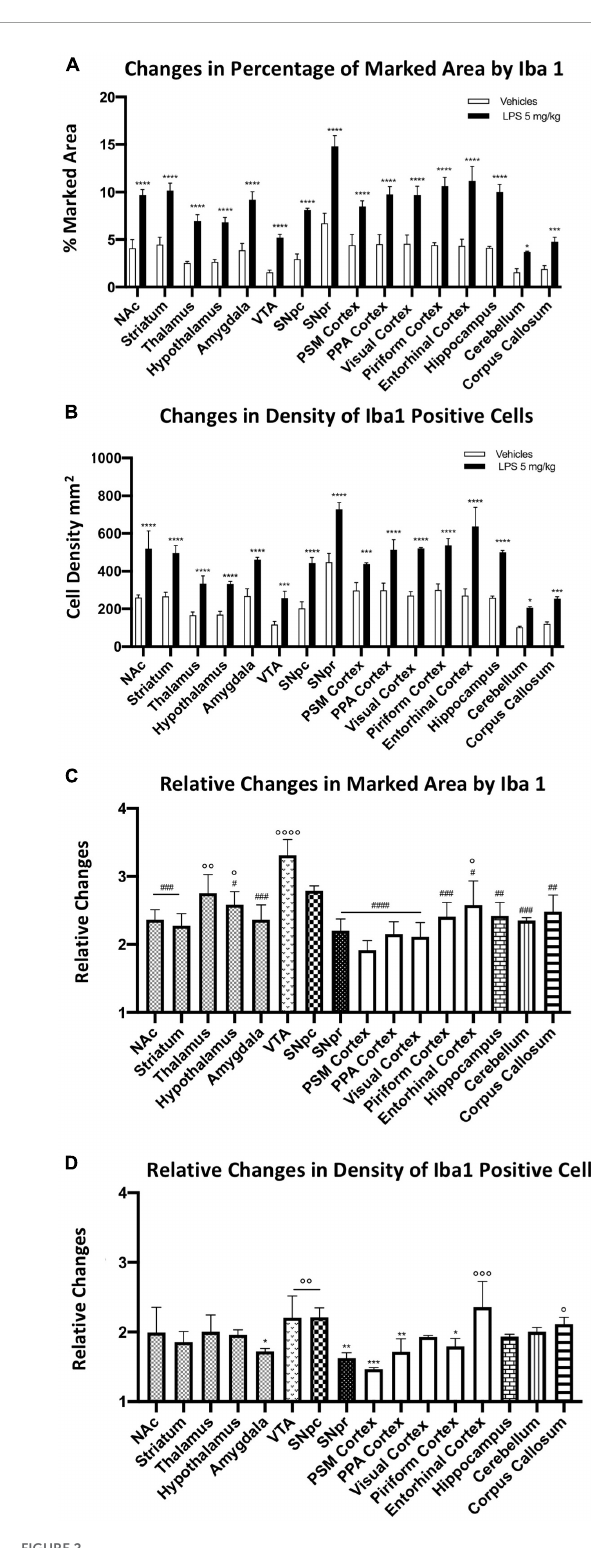
FIGURE2 Heterogeneous microglial alterations 24 h after 5 mg/kg LPS administration. (A) Percentage of the marked area by Iba1 in vehicles (white columns) and LPS treated mice (black columns). Two-way ANOVA F BrainRegions (15, 64) = 46.13, p < 0.0001. F Treatment (1, 64) =